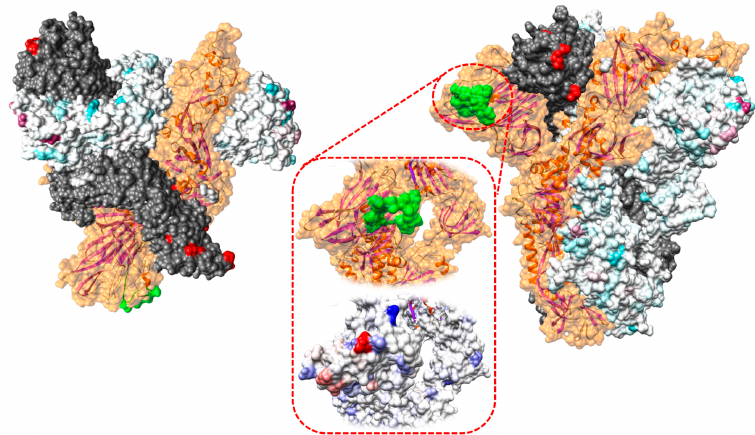
Figure 7. Upper ( left ) and lateral ( right ) view of the quaternary structure of the BoCV spike protein reconstructed using homology modeling. The appearance has been edited to highlight different selective pressure features. In the color-coded monomer, the difference between non-synonymous and synonymous substitution rates (dN–dS), calculated using FUBAR, is reported on the protein surface ranging from purple (dN > dS) to light blue (dN < dS). In the gray-colored monomer, sites under episodic diversifying selection are reported in red. In the remaining monomer, colored in orange, the receptor-binding domain (RBD) is highlighted in green. In the transparency, the ribbon structure is visualized. In the central insert, the RBD is magnified (upper image), and the strength of selective pressures (lower image) acting in that region is represented using the previously described scale. A more detailed representation of the overall protein structure is reported in the Animations (S1 and S2). Table 2. Codons of the spike protein detected under statistically significant diversifying selection using different methods. The difference between non-synonymous and synonymous substitution rates (dN–dS) and respective significance level ( p -value or posterior probability) are reported. FEL FUBAR SLAC Position dN-dS p -Value dN-dS Posterior Probability dN-dS p -Value